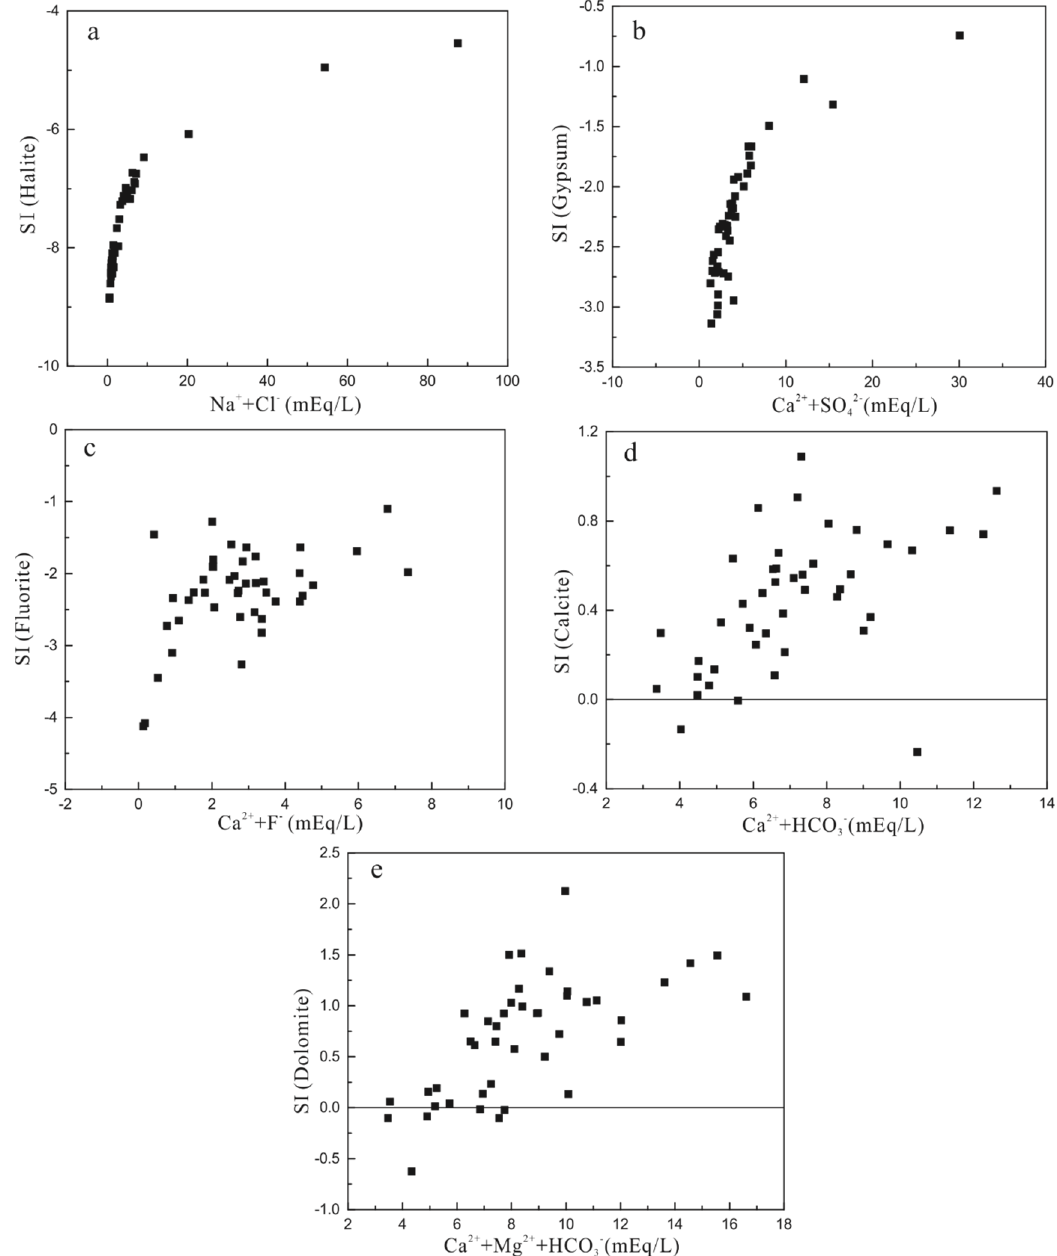
Figure 7. SI plots for the groundwater in the study area (( a ). Na + + Cl − vs. SI (Halite) ( b ). Ca 2+ + SO 42 − vs. SI (Gypsum) ( c ). Ca 2+ + F − vs. SI (Fluorite) ( d ). Ca 2+ + HCO 3 − vs. SI (Calcite) ( e ). Ca 2+ + Mg 2+ + HCO 3 − vs. SI (Dolomite)).